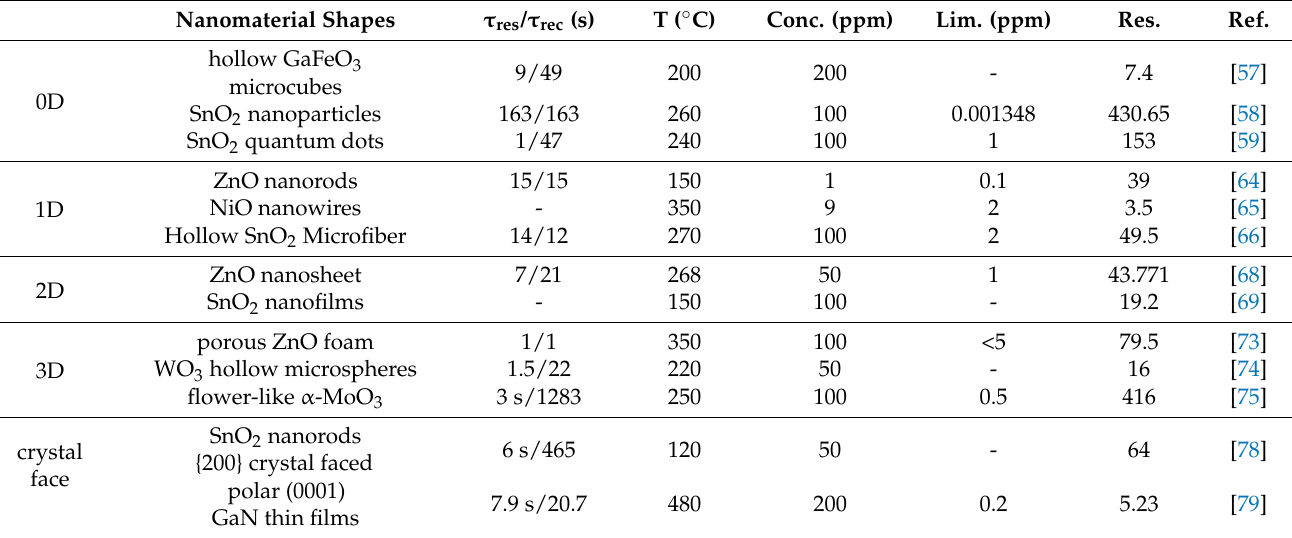
Table 2. TEA-sensing properties of different gas-sensing material